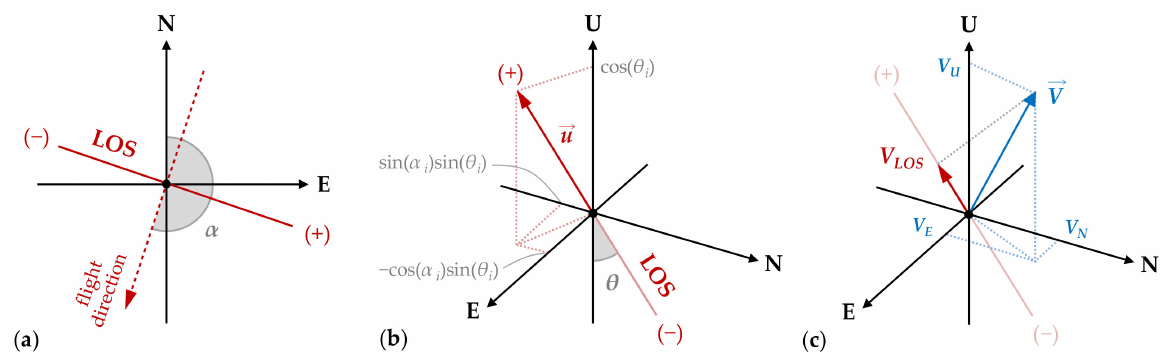
Figure 2. Orientation of the satellite Line-Of-Sight (LOS) in ( a ) the horizontal plane and ( b ) 3D, and ( c ) projection of the → V along the LOS. The sketches refer to a descending orbit and the right-looking acquisition geometry. LOS velocity vector orientation is according to the established assumption of negative displacement values indicating movements away from → u (with length = 1). Notation: α , heading angle; θ , incidence the sensor. Directional cosines refer to a unit vector